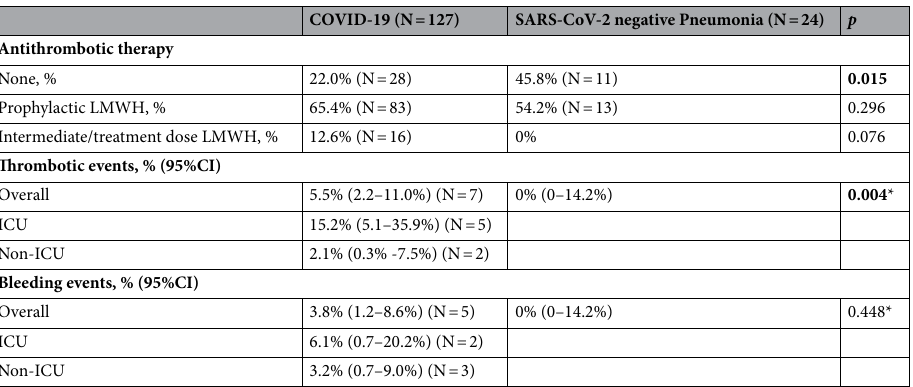
Table 2. Antithrombotic therapies and vascular events in COVID-19 patients and with SARS-CoV-2 negative pneumonia. Bold values denote statistical significance at the p < 0.05 level. ICU intensive care unit, LMWH low molecular weight heparin. * p value of 0.013 for thrombotic events in ICU vs. non-ICU COVID-19 patients, and p value of 0.604 for bleeding events in ICU vs. non-ICU COVID-19